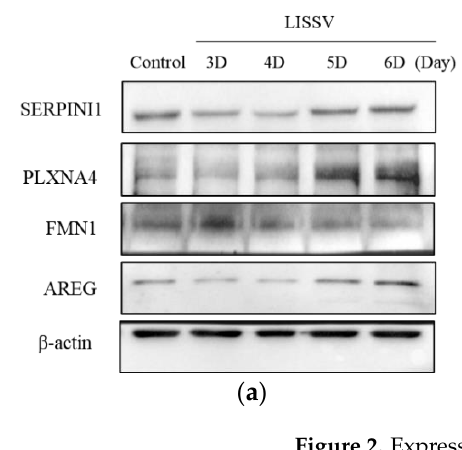
Figure 2. Expression of each protein in human umbilical-cord-derived mesenchymal stem cells after low-intensity sub-sonic vibration treatment. Proteins detected were Serpin Family I Member 1 (SERPINI1), Plexin A4 (PLXNA4), Formin 1 (FMN1), and Amphiregulin (AREG). ( a ) Western blot image. ( b ) Intensities of each Western blot band were quantified by Image J. Each band was normalized using β -actin. Column heights correspond to mean values and error bars to standard deviations ( n = 3). * p < 0.05, ** p < 0.01 .